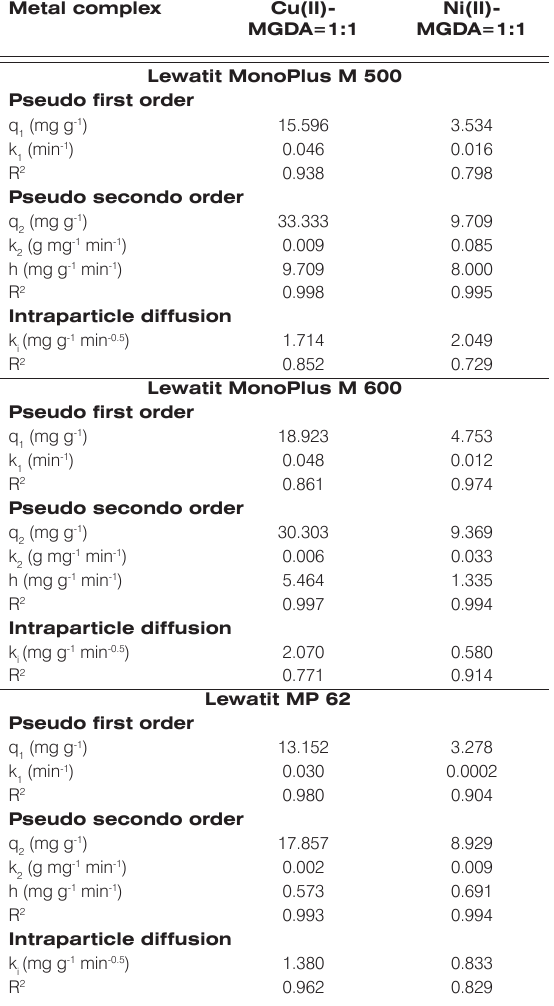
parameters for Cu(II) and Ni(II) ions in the presence of MGDA on Lewatit MonoPlus M 500, Lewatit MonoPlus M 600 and Lewatit MP Cu(II)- MGDA=1:1